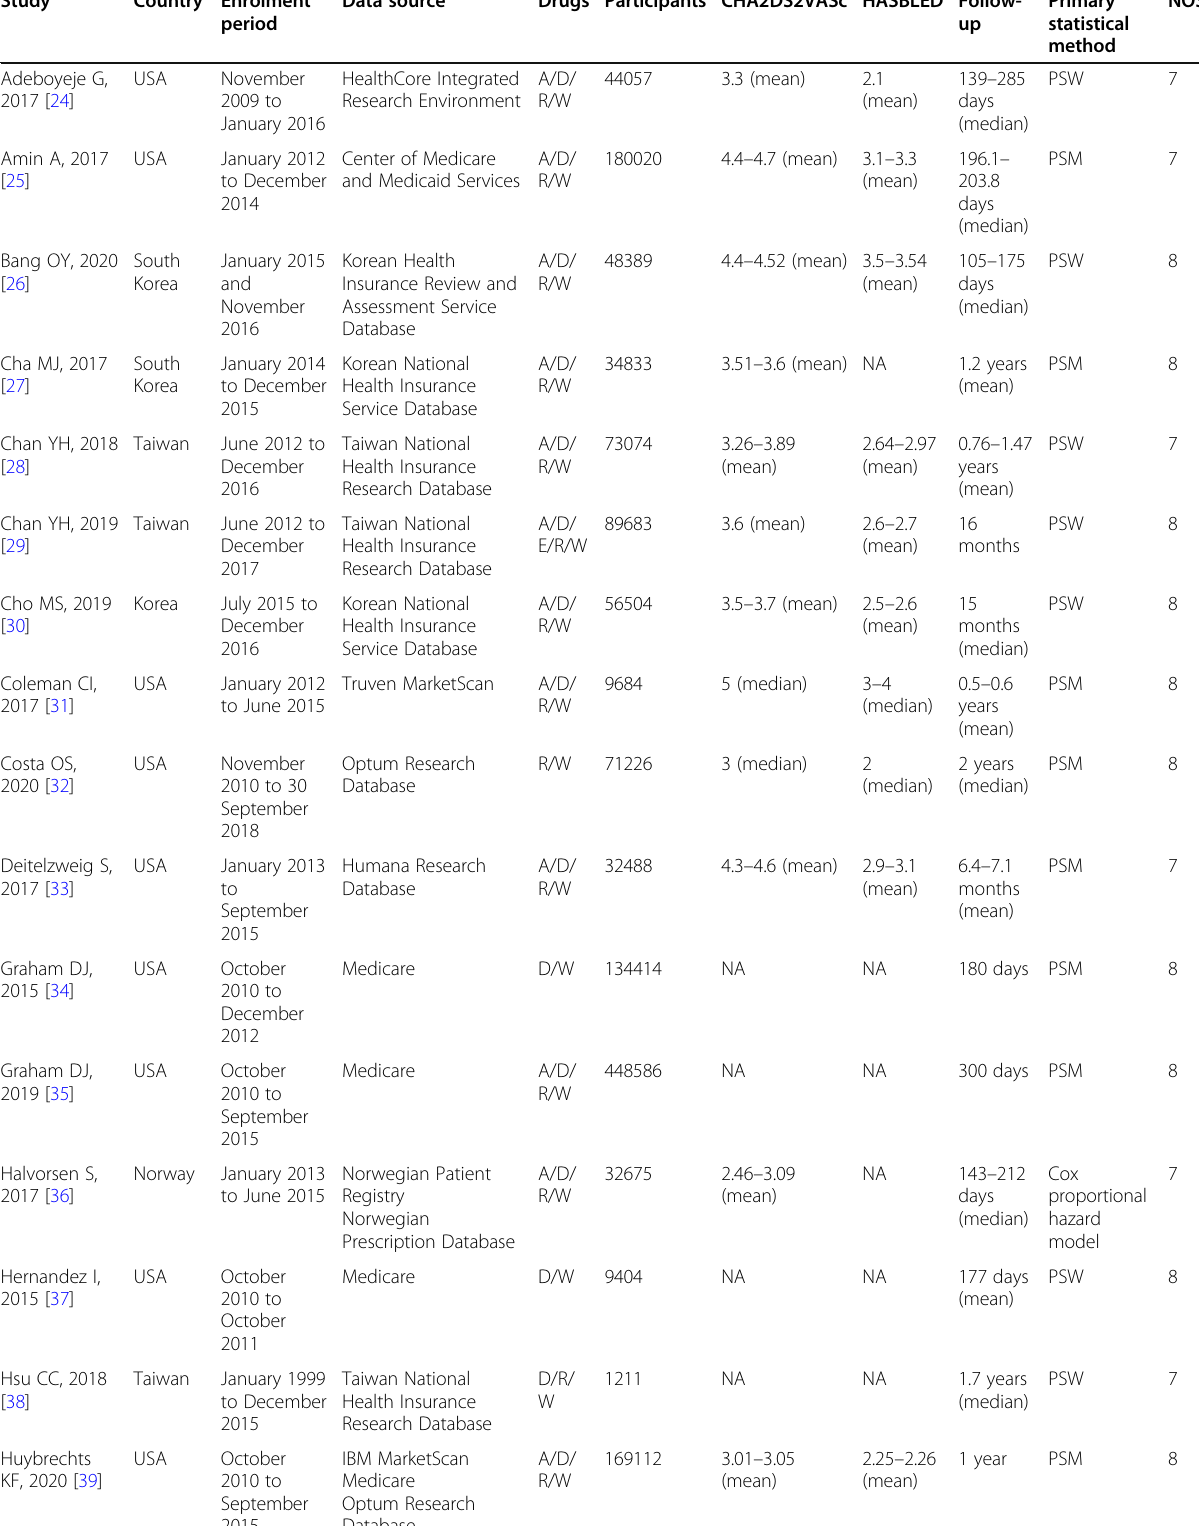
Table 1 Baseline characteristics of the